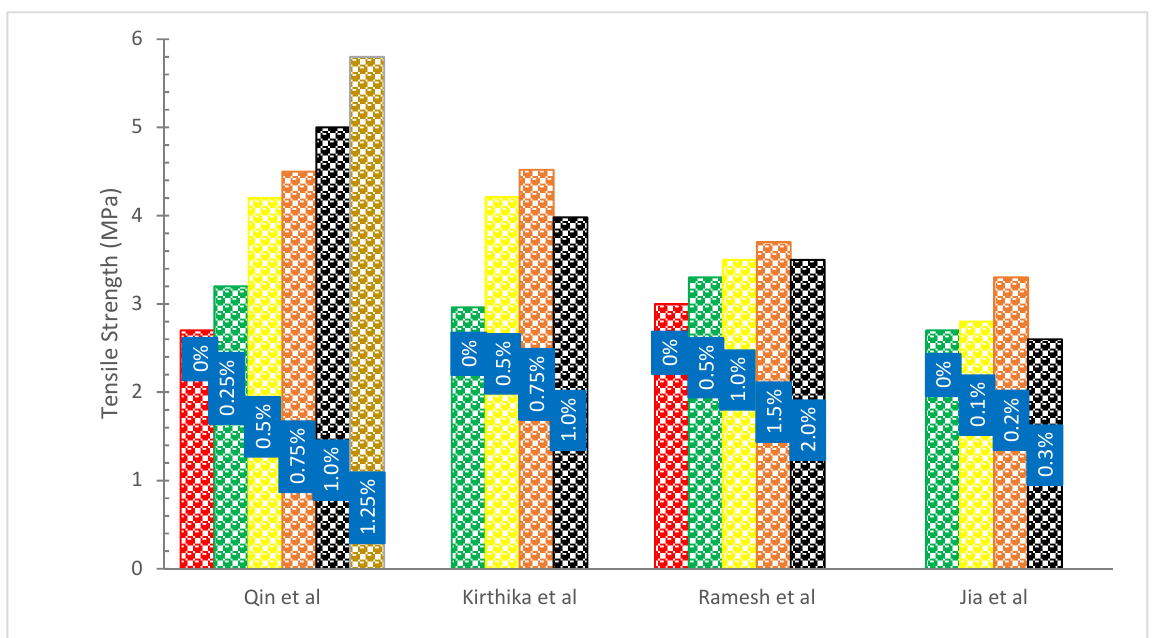
Figure 9. Tensile Strength: Data Source [35,50,67,70].